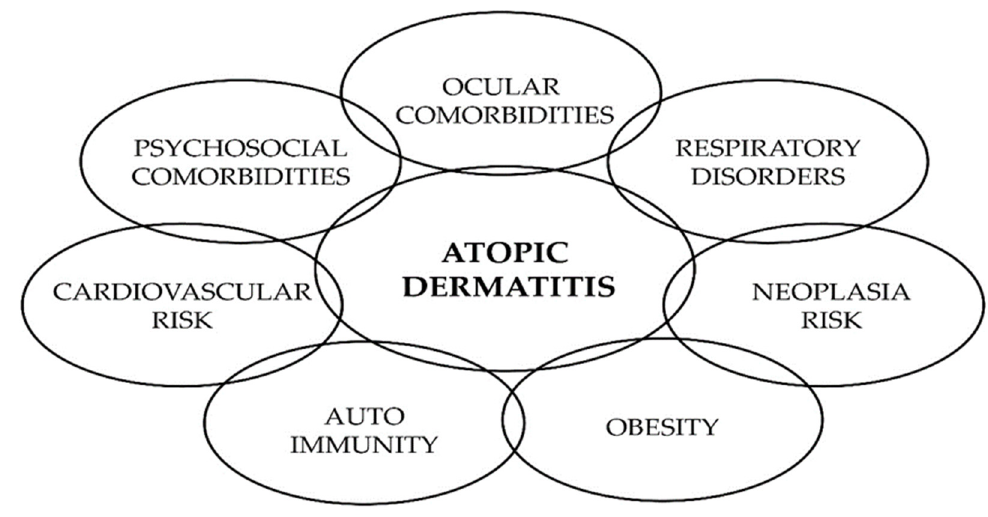
Figure 2. Common comorbidities of atopic dermatitis.